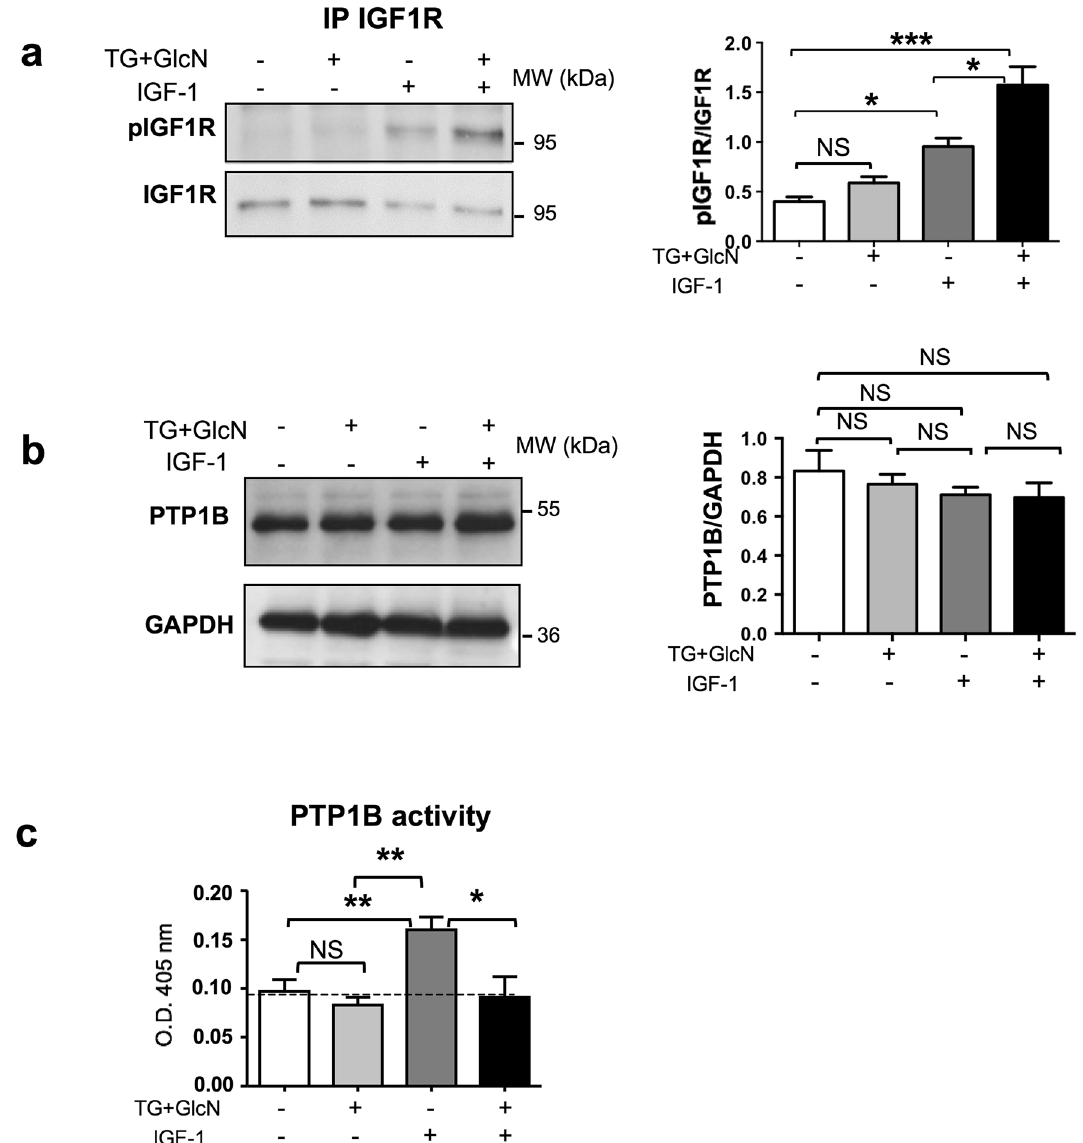
Figure 3. Effect of O -GlcNAcylation-inducing treatments on IGF-1R phosphorylation and PTP1B expression and activity in CaSki cells. CaSki cells were cultured in the presence of 1% FBS in the absence or presence of TG (10 µM for 24 h) and GlcN (5 mM for 6 h). Cells were then stimulated with IGF-1 (5 nM) during 10 min. ( a ) CaSki cells were lysed and IGF1R were immunoprecipitated with an anti-IGF1R antibody. IGF1R phosphorylation was analysed by western blotting using an anti-phospho-IGF1R antibody. The blots were reprobed with an anti-IGF1R antibody (the uncropped western-blots are shown on the Supplementary Information file S1). The histogram represents the ratio of P-IGF1R/IGF1R signal obtained by densitometric analysis of the blots. Results are the means ± SEM of 3 independent experiments. ( b ) CaSki cells were cultured in presence of 1% FBS in the absence or presence of TG (10 µM for 24 h) and GlcN (5 mM for 6 h). Cells were then stimulated with IGF-1 (5 nM) during 10 min. Cells were lysed and PTP1B expression was evaluated by western- blotting (the uncropped western-blots are shown on the Supplementary Information file S1). The histogram represents the ratio of PTP1B/GAPDH signal obtained by densitometric analysis of the blots. Results are the means ± SEM of 4 independent experiments. ( c ) Cell lysates were immunoprecipitated using an anti-PTP1B antibody and PTP1B activity was measured using p-nitrophenyl-phosphate (pNPP) as a substrate. Histograms represent the means ± SEM of PTP1B enzymatic activity (optical density at 405 nm) in 4 independent experiments. Statistical analysis was performed using ANOVA followed by Tukey’s post-test. *; **; ***p < 0.05, p < 0.01, and p < 0.001, respectively. NS